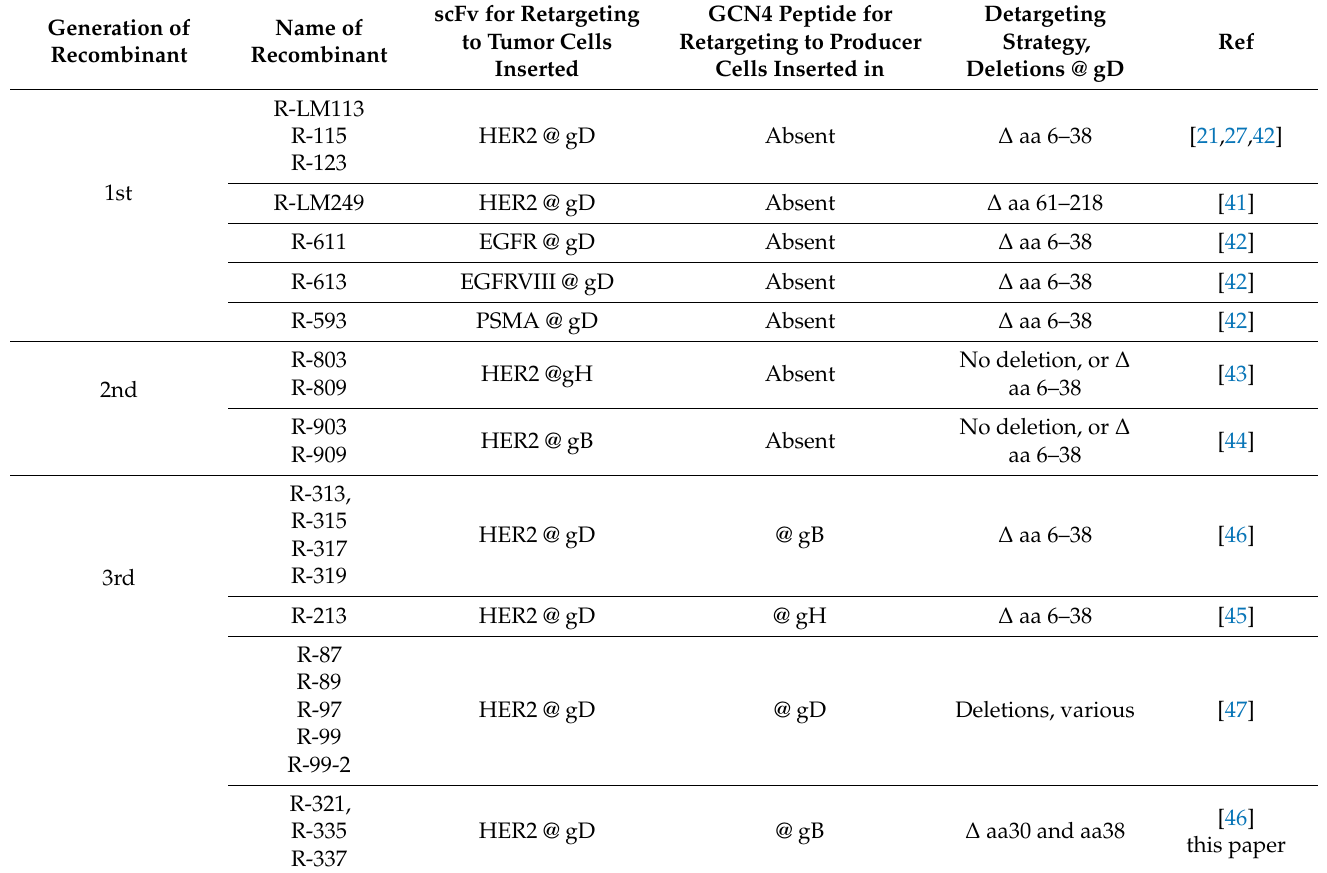
Table 1. 1st, 2nd and 3rd generation retargeted oHSV, genotypic modifications for retargeting and detargeting purposes. Generation